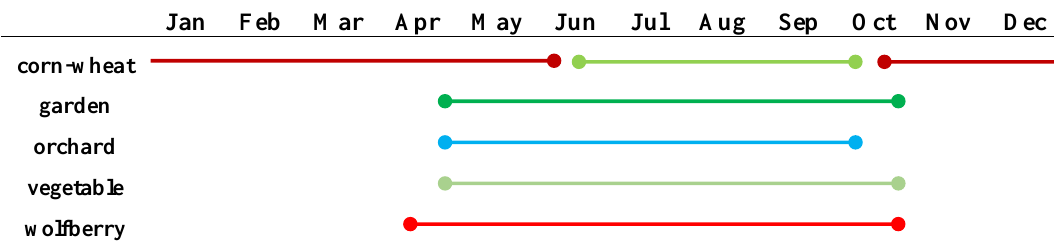
Table 3. Crop phenology characteristics in Zhongning County.